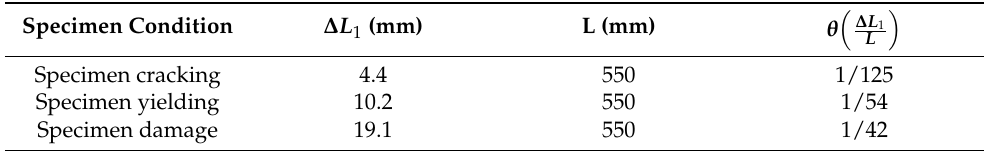
Table 9. Displacement angle of specimen J1.